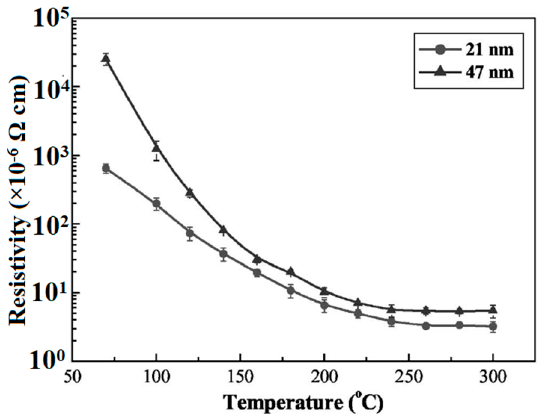
Figure 2. Decreasing the resistivity of the thin film composed of Ag NPs (with different size of 21 and 47 nm) by increasing the sintering temperature. Reproduced with permission from [13]. Copyright 2005 ECS Publishing.